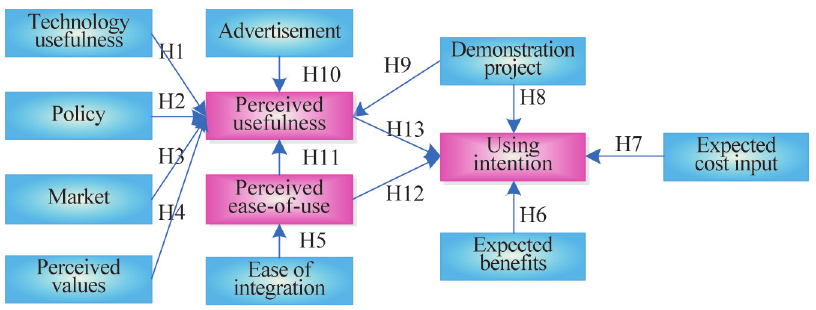
Figure 3. Conceptual